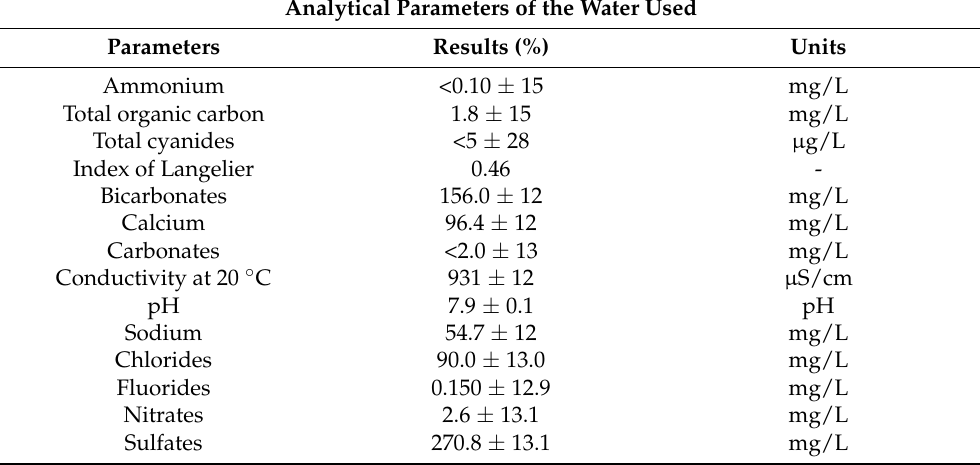
Table 1. Analytical parameters of the water used in the preparation of the mortars (Source: Aquagest Levante,